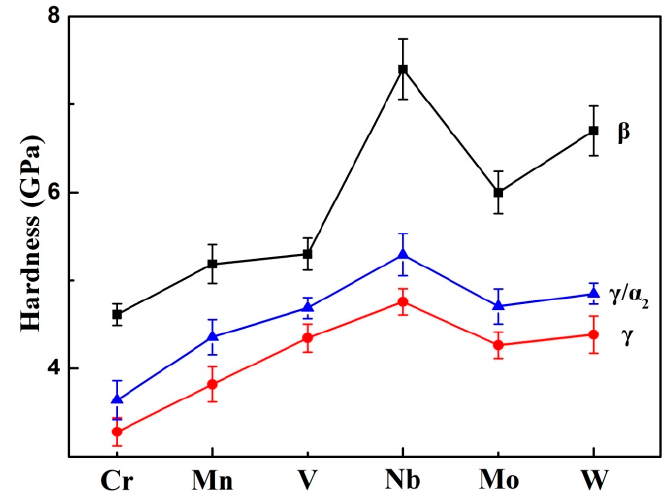
Figure 8. The e ff ect of β stabilizers on the hardness of constituent phases in TiAl Figure 8. The effect of β stabilizers on the hardness of constituent phases in TiAl alloys.